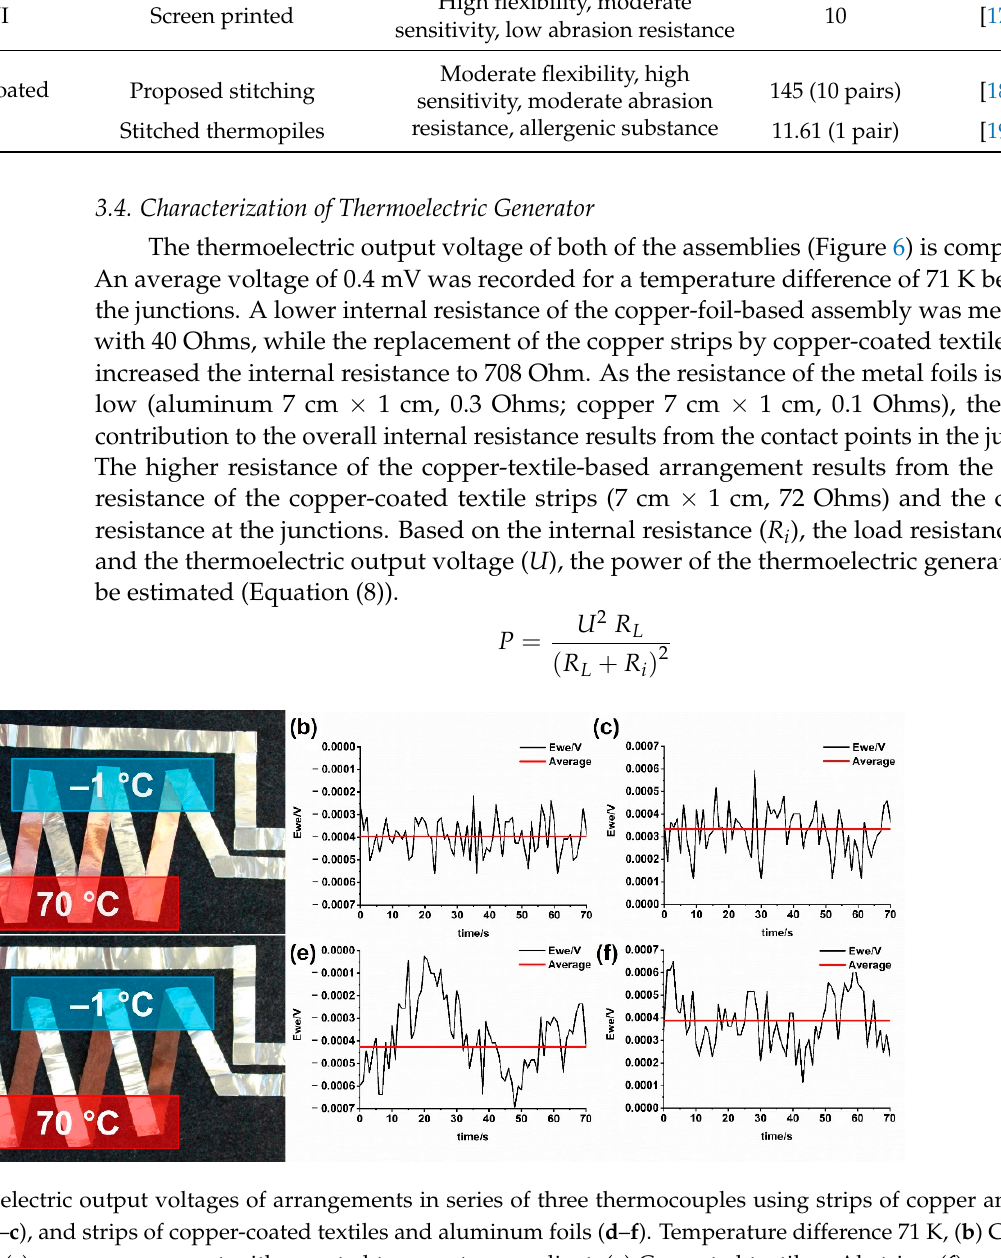
Table 3. Overview of different energy harvesting devices, designed to be integrated into textiles.